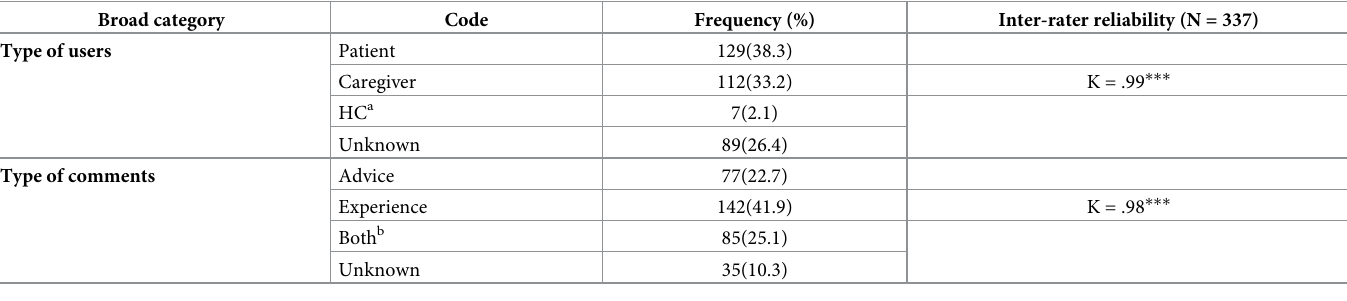
Table 2. List of broad categories, related code, and inter-rater reliability analysis. Broad